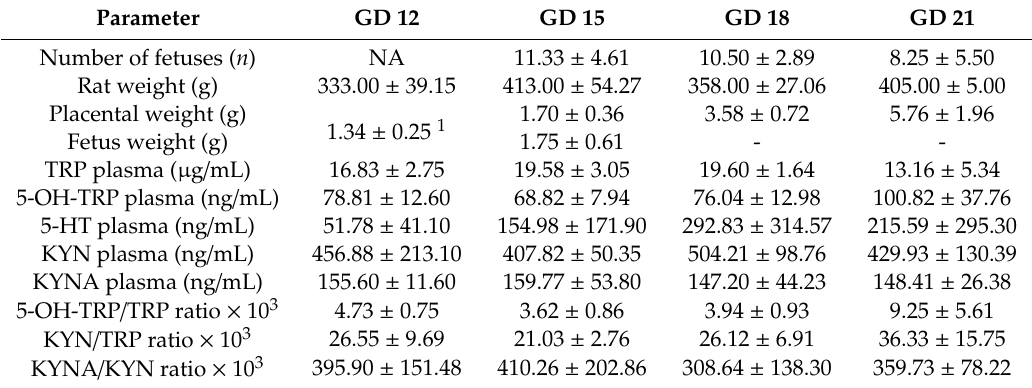
Table 1. Descriptive Statistics of the Pregnant Wistar Rats Used in the Study and Biochemically Assayed Metabolite Concentrations in Maternal Plasma. Results Are Expressed as the Mean ± SD; n = 5.